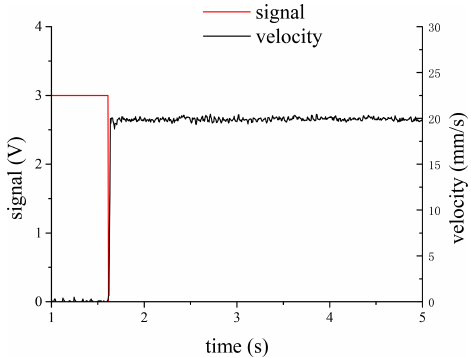
Figure 13. Response of the motor screw pair.